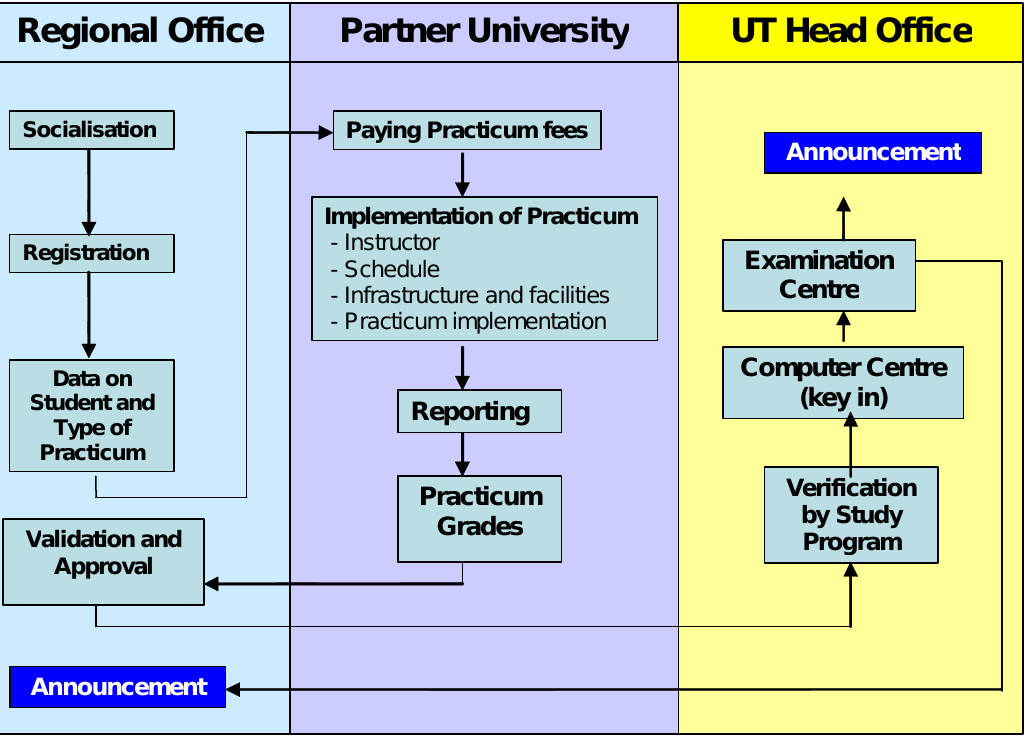
Figure 3. Science practicum